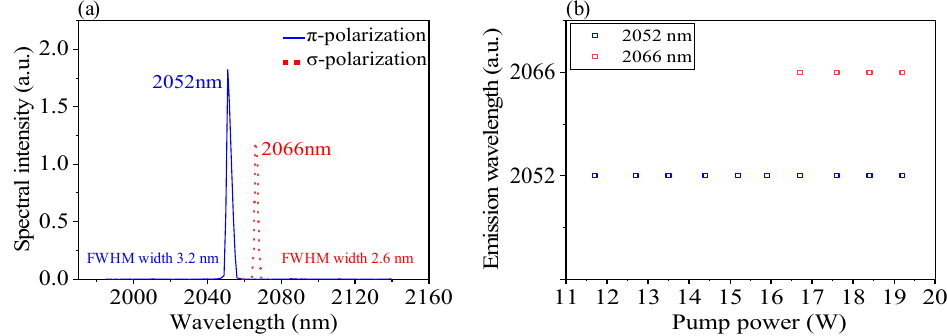
Figure 5. ( a ) Optical spectra of the orthogonally polarized dual-wavelength Ho:LLF laser and ( b ) emission wavelengths of the Ho:LLF laser with respect to pump power.